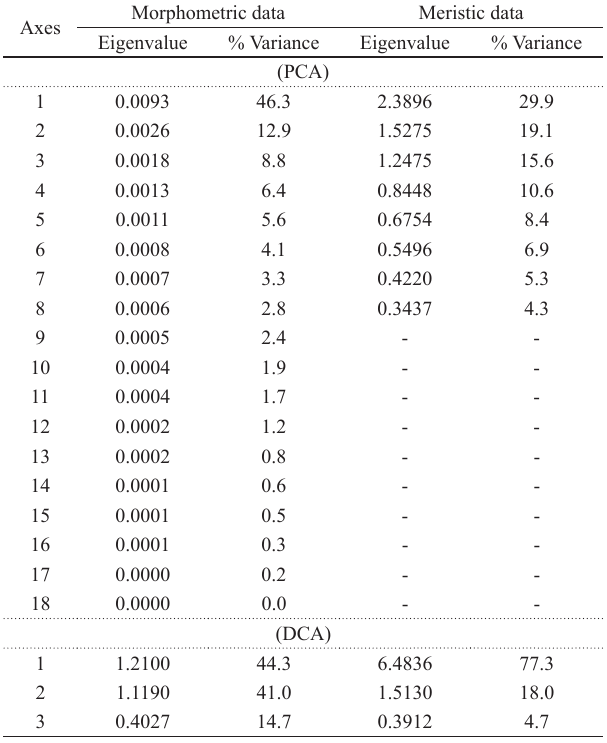
Tab. 2. Results of the principal components analyses (PCA) and discriminant canonical analyses (DCA) of the adjusted morphological data of Moenkhausia bonita .